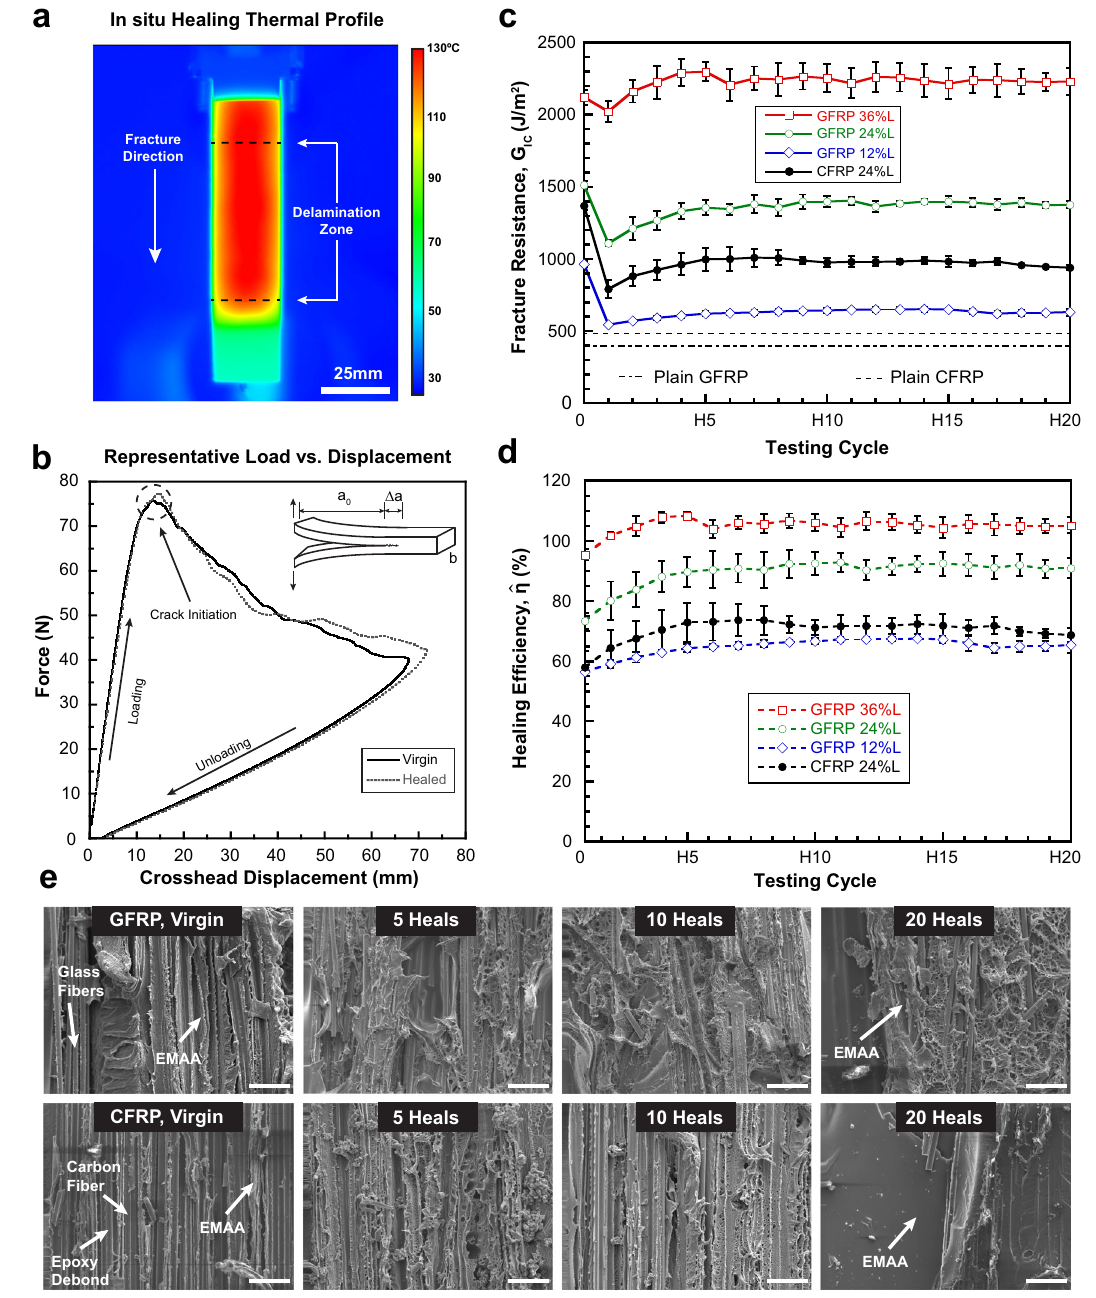
Fig. 4 | Mode-I fracture and in situ self-healing performance. a Top surface temperature distribution of a fractured double cantilever beam (DCB) during a self-healing thermal remending cycle. b Representative load versus displacement behaviorforavirginandself-healedDCBspecimen. c Delaminationresistance(i.e., G IC ) evolution for GFRP and CFRP specimens at various as-printed EMAA areal coverages (12, 24, and 36%) over 20 heal cycles; dashed lines indicate values for plain (unmodi fi ed) composites. Error bars represent the standard deviation from